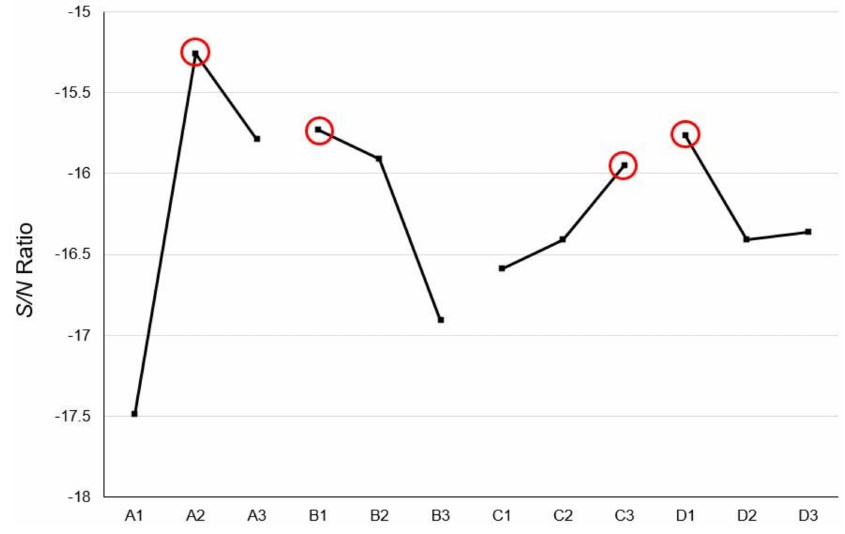
Figure 14. Response graph of S/N ratio (CAE-1024). Table 16. Verification of optimized hyperparameters (CAE-1024).